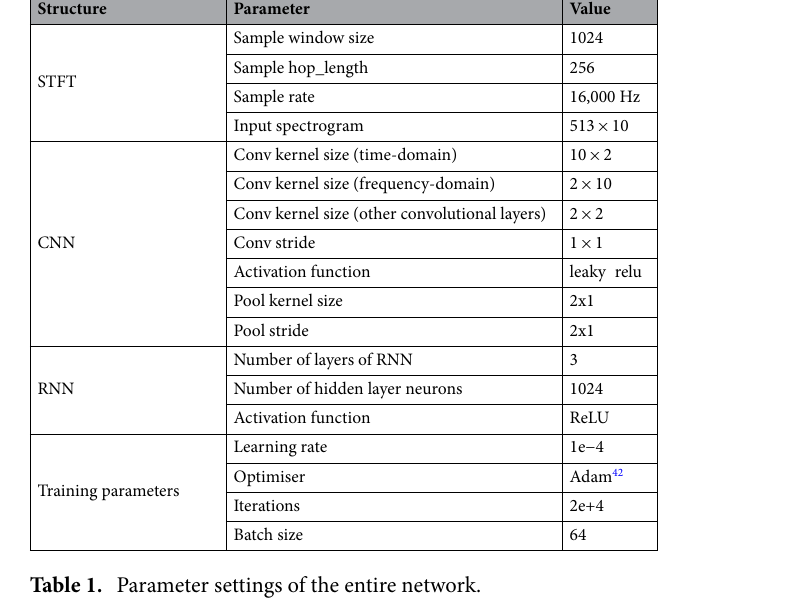
Table 1. Parameter settings of the entire network.